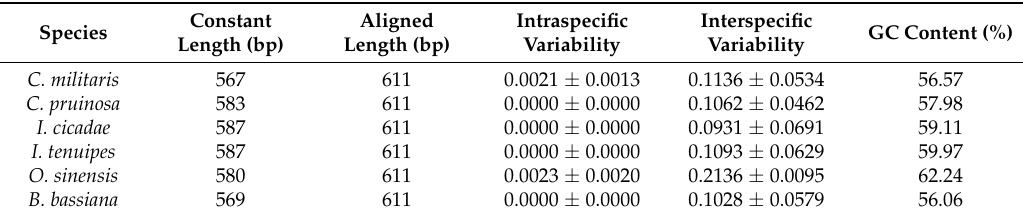
Table 2. Characteristics of the internal transcribed spacer of the ribosomal DNA (nrDNA-ITS)